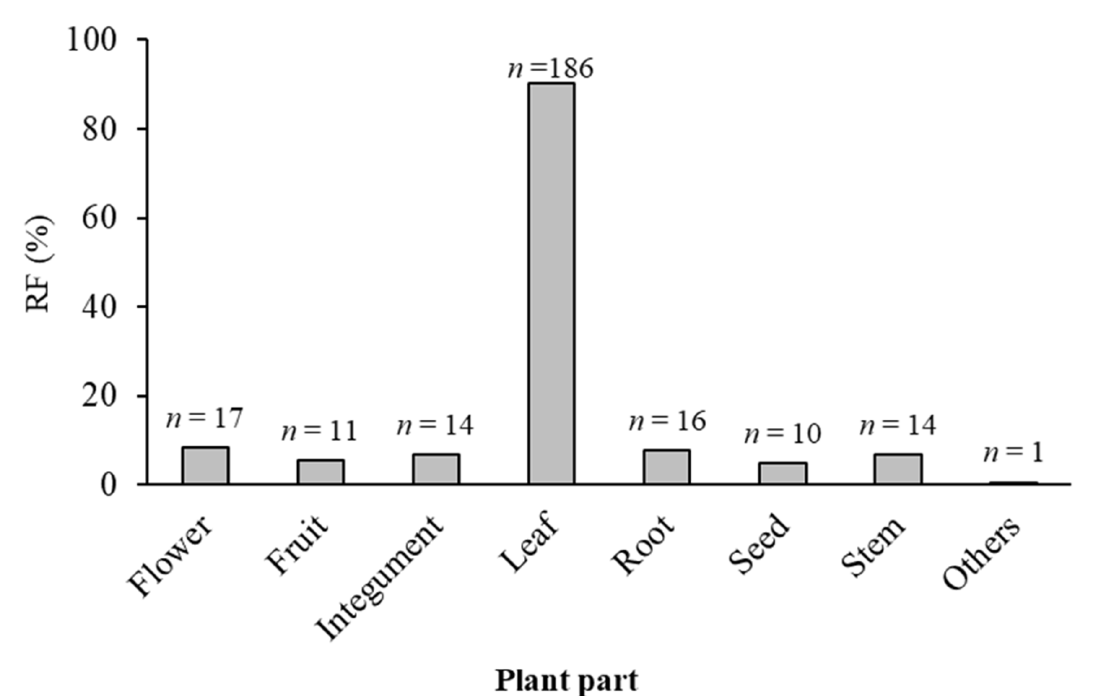
FIGURE 3 – Main parts of the plants used in the medicinal preparations cited by the students and their associated community at a public school in Vila Velha (Brazil). n represents the number of answers for each category considering 206